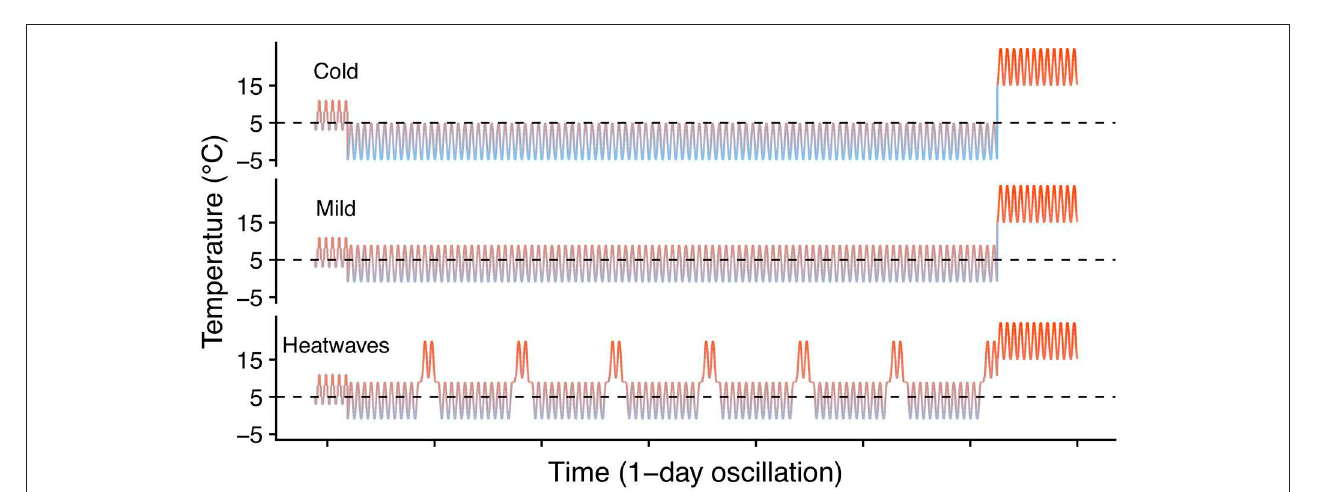
FIGURE 3 | Winter heatwave temperature regimes. Dashed lines indicate 5 ◦ C to facilitate visual comparison among regimes.